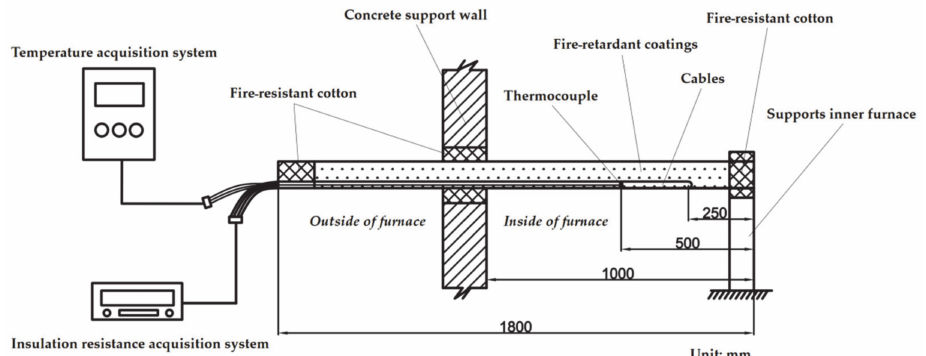
Figure 4. Schematic diagram of horizontally installed